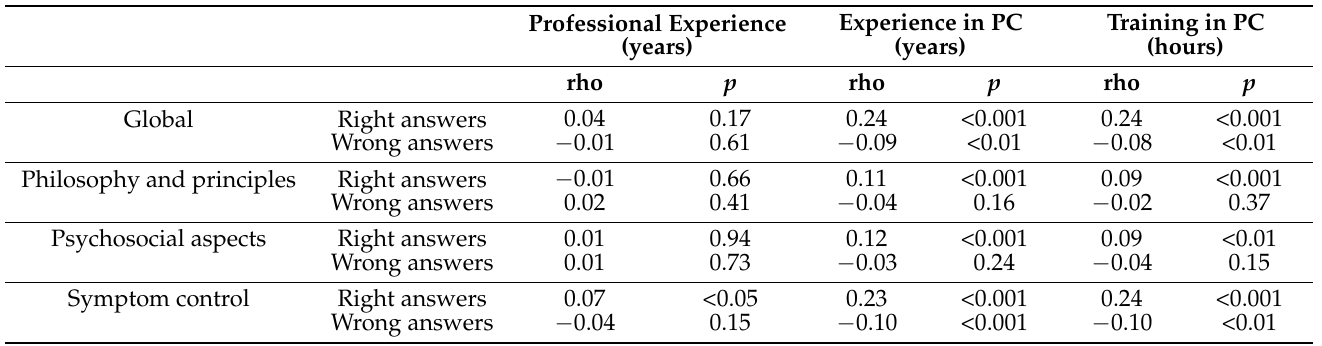
Table 4. Relationship between results obtained in PCQN-SV, years of professional experience (both global and in palliative care), and hours of training in palliative care of the studied population.